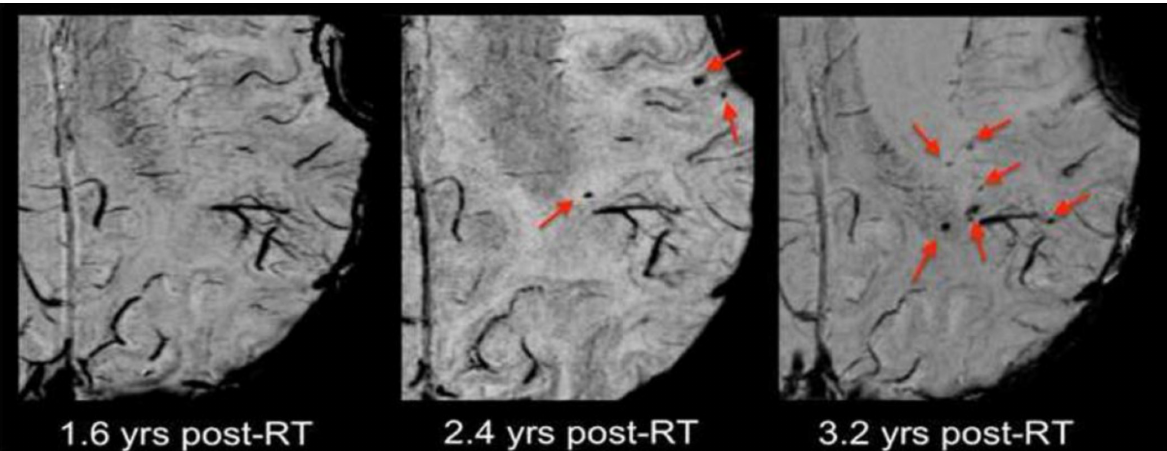
Figure 4. Appearance of microbleeds after RT. Microbleeds did not appear until two years after RT and increased in number (quadruple) three years after radiotherapy. Reprinted from Lupo et al. [108] with permission from